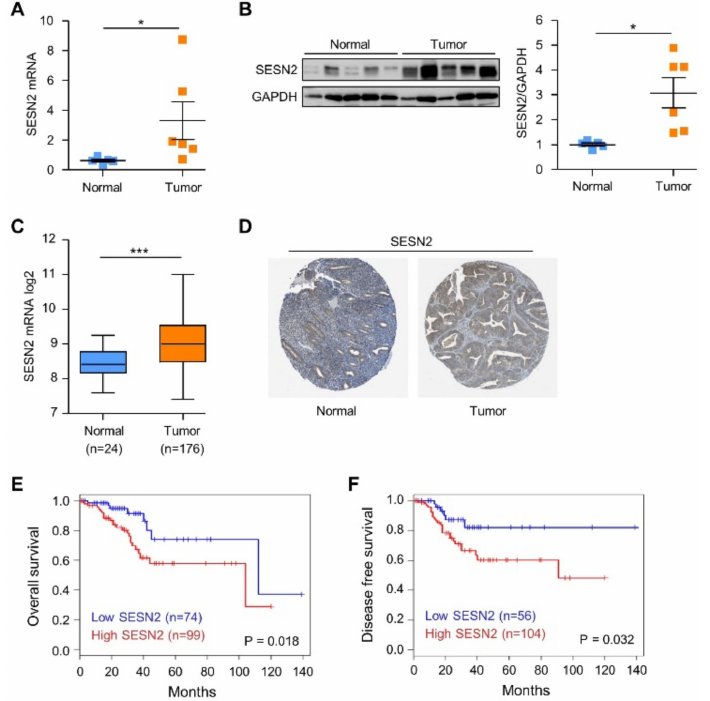
Figure 1. The expression and clinical significance of Sestrin2 (SESN2) in endometrial cancer. ( A ) Relative mRNA expression levels of SESN2 in endometrial cancer ( n = 6) and normal endometrium ( n = 5). The relative mRNA levels of SESN2 in each sample are normalized to that of GAPDH . ( B )